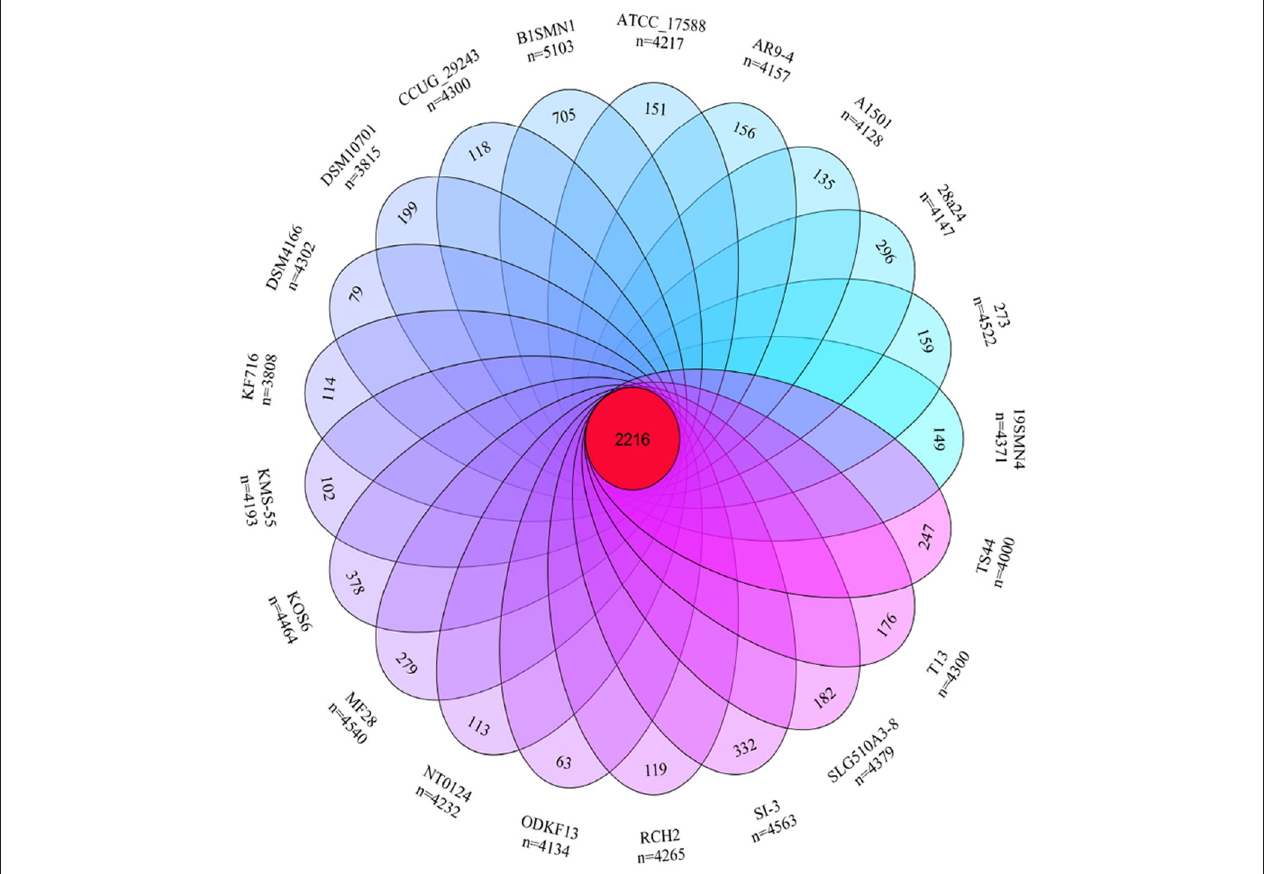
FIGURE 4 | Venn diagram showing the pan- and core-genome of Pseudomonas sp. strain SI-3 and 20 P. stutzeri strains. The center red circle represented the core-genome. The strain name and total gene number of each ellipse presented were marked outside. The specific genes number of each strain was marked in corresponding ellipse.